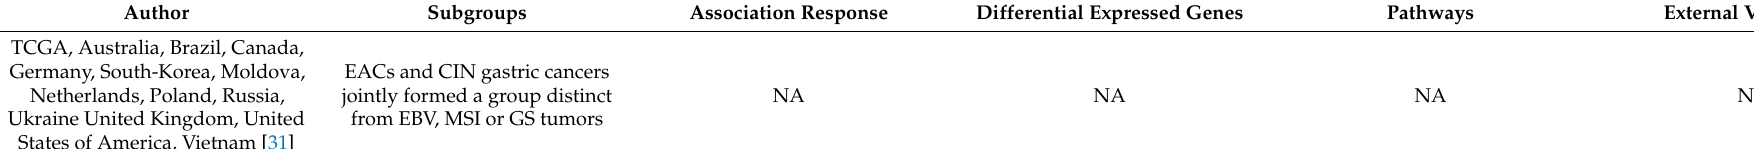
Table 2. Summary of results from studies discussed in Section